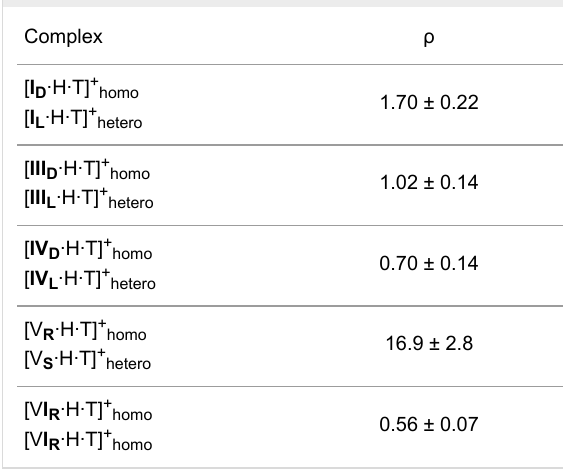
Table 1: Exchange rate constants ( k × 10 − 11 cm 3 molecule − 1 s − 1 ).